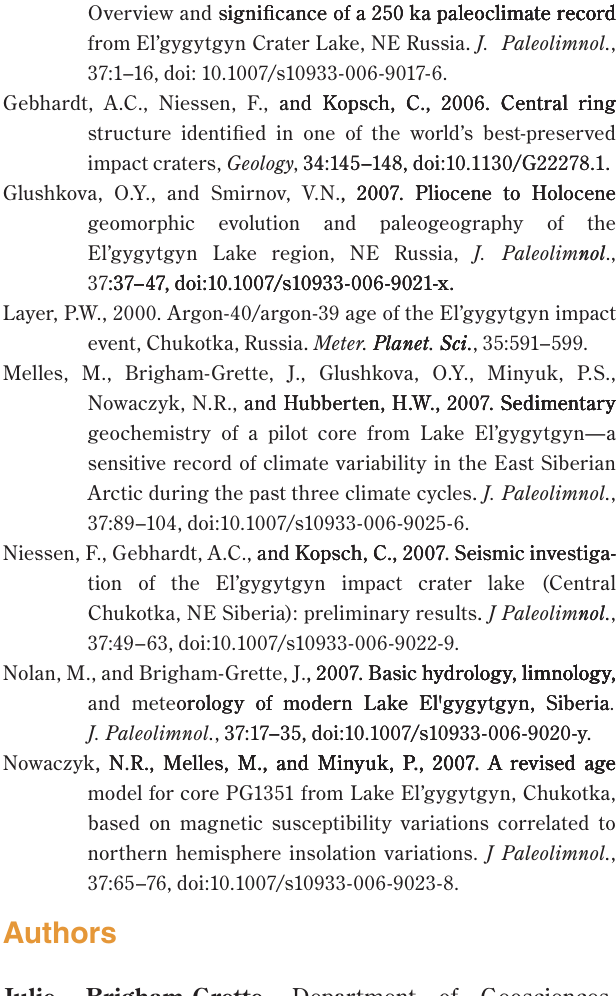
Fig. 1: [A] photo by Conrad Kopsch, AWI; [B] photo by VolkerConrad Kopsch, AWI; [B] photo by Volker; [B] photo by VolkerVolker Wennrich, University of Cologne; [C] base map courtesy of; [C] base map courtesy ofbase map courtesy of Fig. 2: photo by David Zur,